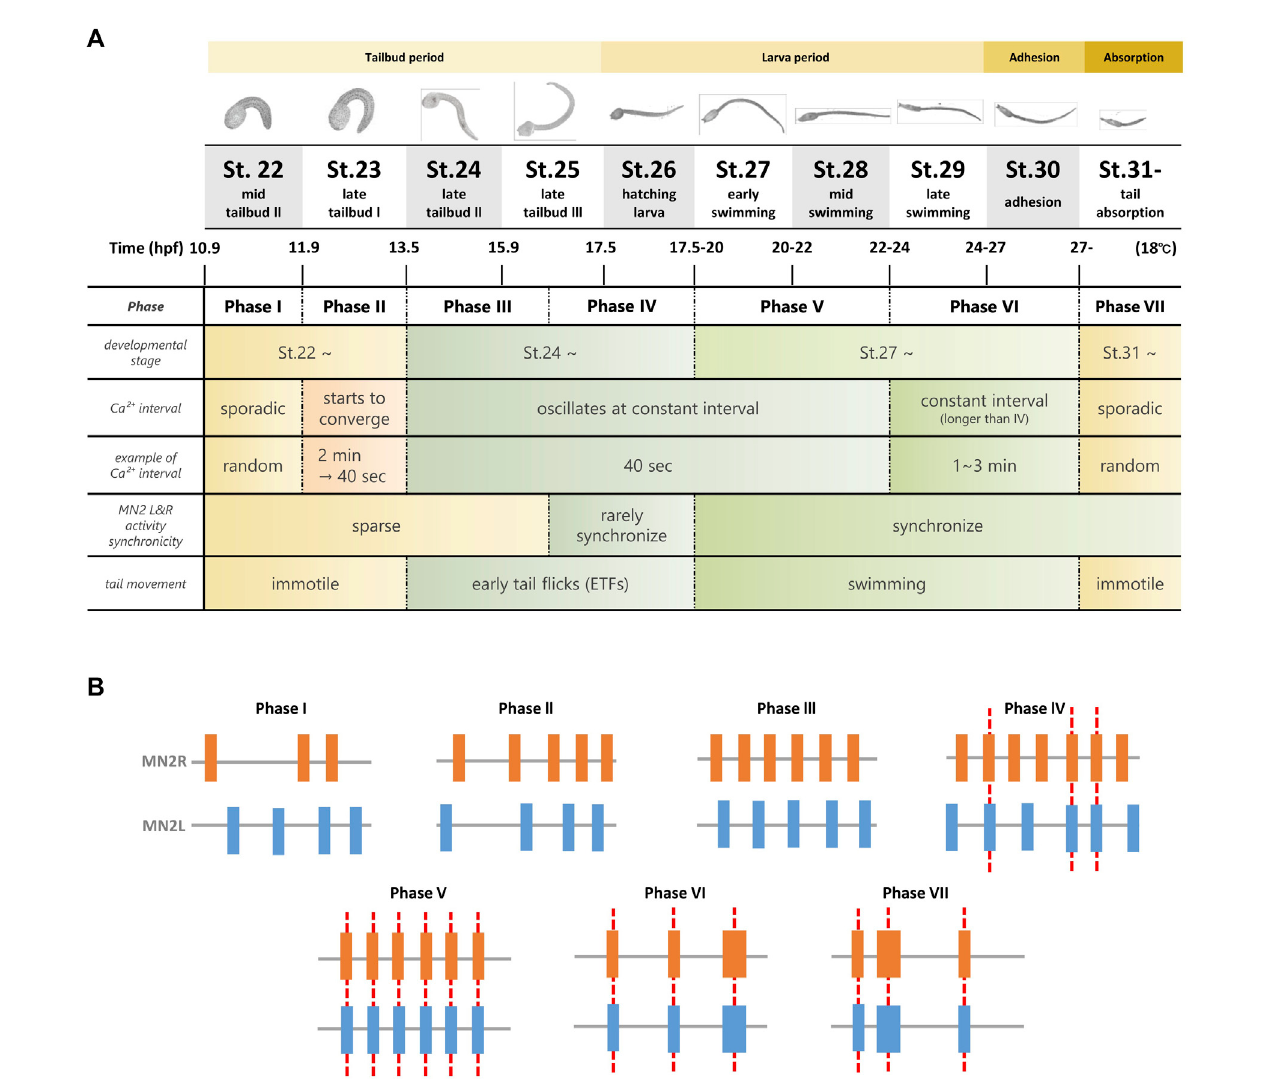
FIGURE 7 SummaryofthesevenPhasesofMN2LandMN2RCa 2+ transientsobservedfromtailbudstagetotailabsorption. (A) Ca 2+ transientswereobservedduring tailbud,swimminglarva,adhesion,andtailabsorptionperiods(showninyellowband).Long-termsimultaneousCa 2+ imagingofMN2swithGCaMP6s/f(St.22- )revealed that their activities could beclassi fi edinto seven phases(PhaseIto Phase VII), depending on theinterval and synchronicity ofMN2L and MN2R Ca 2+ transients.Initially,eachMN2oscillatessporadically(PhaseI);astheydevelopintoswimminglarvae,theygraduallyoscillateataconstantinterval(PhaseII - Phase III), rarely synchronize (Phase IV), synchronize from the swimming larva period (Phase V), oscillate at a longer interval (Phase VI), and start to exhibit sporadic bursts during the tail absorption period (Phase VII). (B) Schematic illustration of Ca 2+ transients from Phase I to Phase VII. Red dotted lines indicate synchronization of Ca 2+ bursts between MN2L and